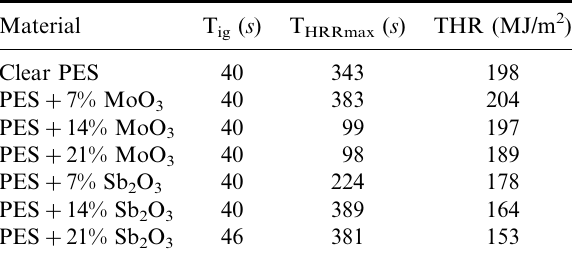
Table 6. Thermokinetic properties of unmodified and mod- ified polyester materials at the heat flux density of 50 kW/m 2 on piloted ignition (cid:2) Part 2